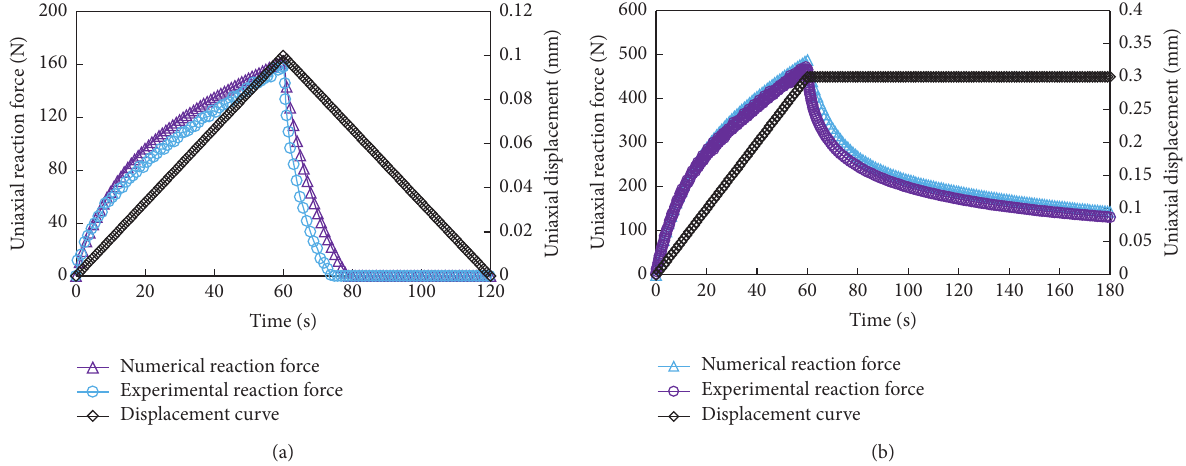
Figure 5: Simulated and experimental compression results of displacement-based loading, (a) loading and unloading and (b) loading and holding